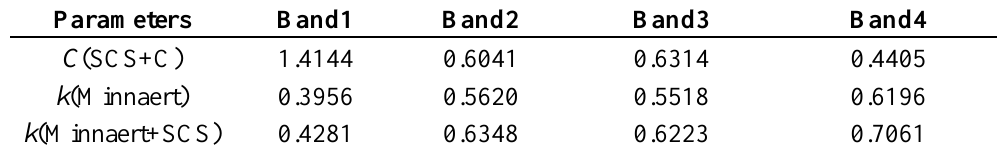
Table 3. Parameters of correction models * for the ZY-3 multispectral bands.